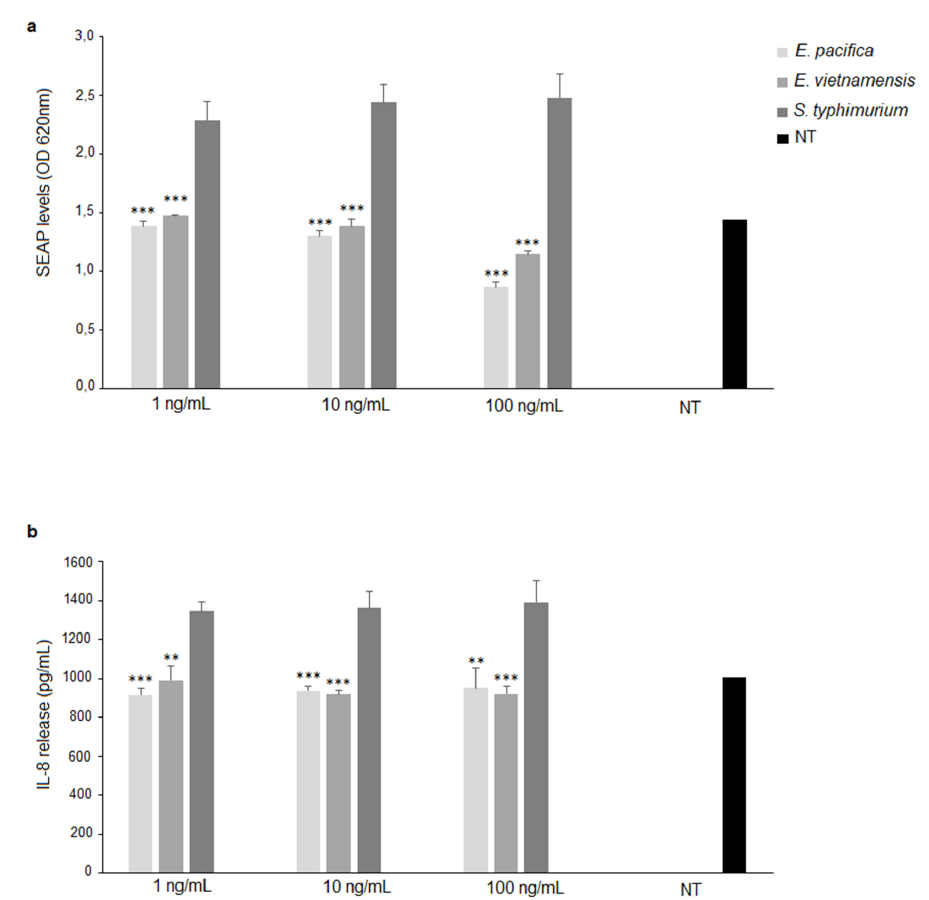
Figure 7. Stimulation of HEK Blue TM hTLR4 cells. SEAP levels (OD) ( a ) and IL-8 release (pg/mL) ( b ) upon stimulation with LPS of E. pacifica KMM 6172 T (1, 10, 100 ng/mL) or E. vietnamensis KMM 6221 T LPS (1, 10, and 100 ng/mL); S. typhimurium SH 2201 LPS was used as positive control. Significant differences between E. pacifica KMM 6172 T LPS or E. vietnamensis KMM 6221 T LPS and S. typhimurium LPS values are indicated. ** p < 0.01, *** p < 0.001 by the Student t -test. NT, not treated cells. Data are expressed as mean ± SD of three independent experiments in